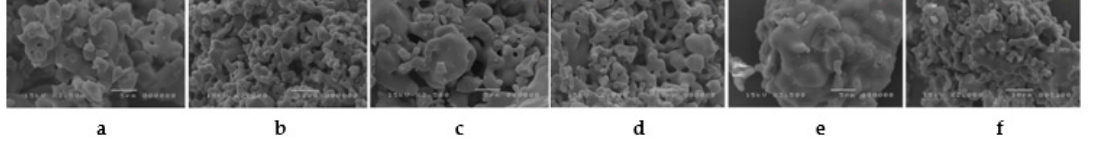
Figure 5. SEM images of synthetic HAp samples with different morphologies: porous aggregates ( a – c ); massive fragments and compact aggregates ( d – f ).